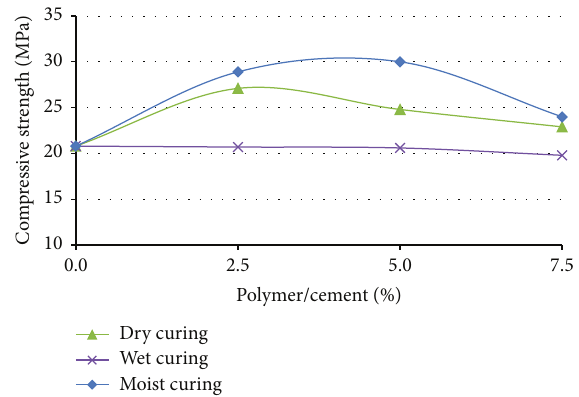
Figure 13: Splitting tensile strength at age of 28 days.